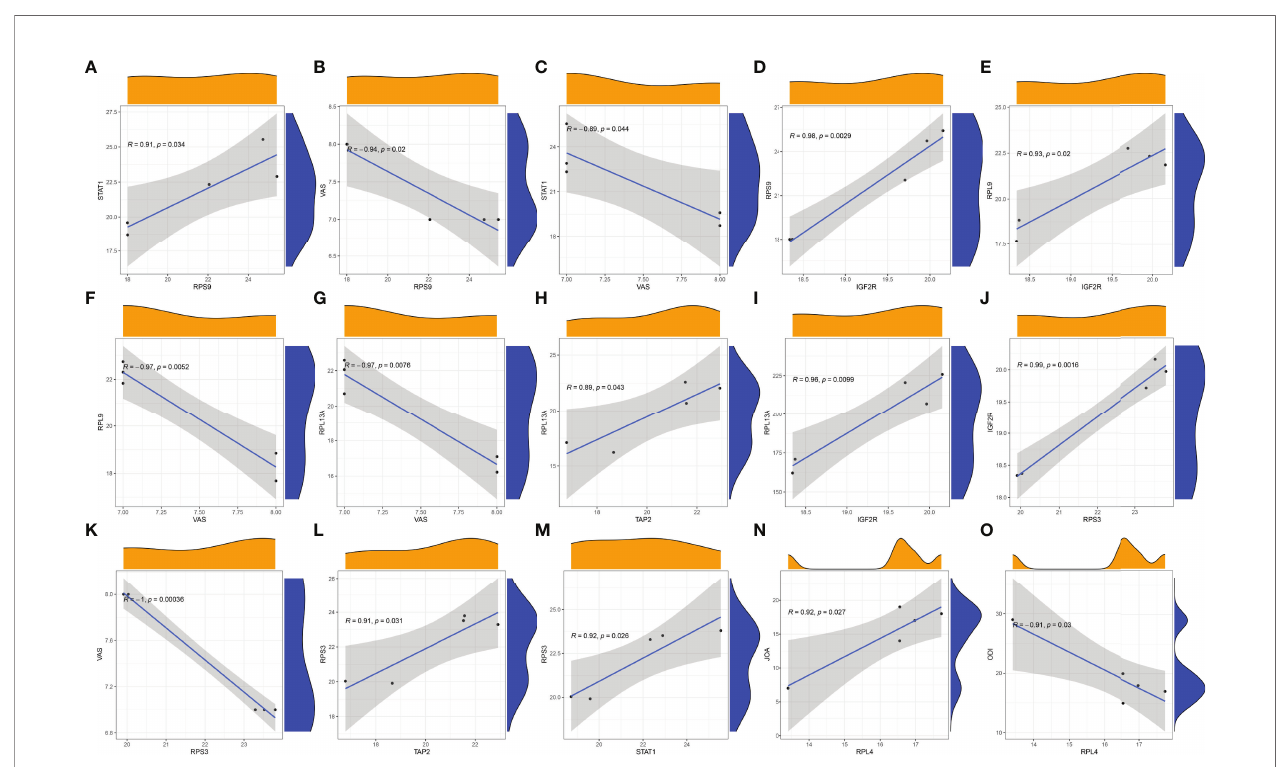
FIGURE 11 | Correlation analysis was plotted. (A) Correlation analysis of STAT1 and RPS9. (B) Correlation analysis of RPS9 and VAS. (C) Correlation analysis of STAT1 and VAS. (D) Correlation analysis of IGF2R and RPS9. (E) Correlation analysis of RPL9 and IGF2R. (F) Correlation analysis of RPL9 and VAS. (G) Correlation analysis of RPL13A and VAS. (H) Correlation analysis of RPL13A and TAP2. (I) Correlation analysis of IGF2R and RPL13A. (J) Correlation analysis of IGF2R and RPS3. (K) Correlation analysis of RPS3 and VAS. (L) Correlation analysis of RPS3 and TAP2. (M) Correlation analysis of STAT1and RPS3. (N) Correlation analysis of RPL4 and JOA. (O) Correlation analysis of RPL4 and